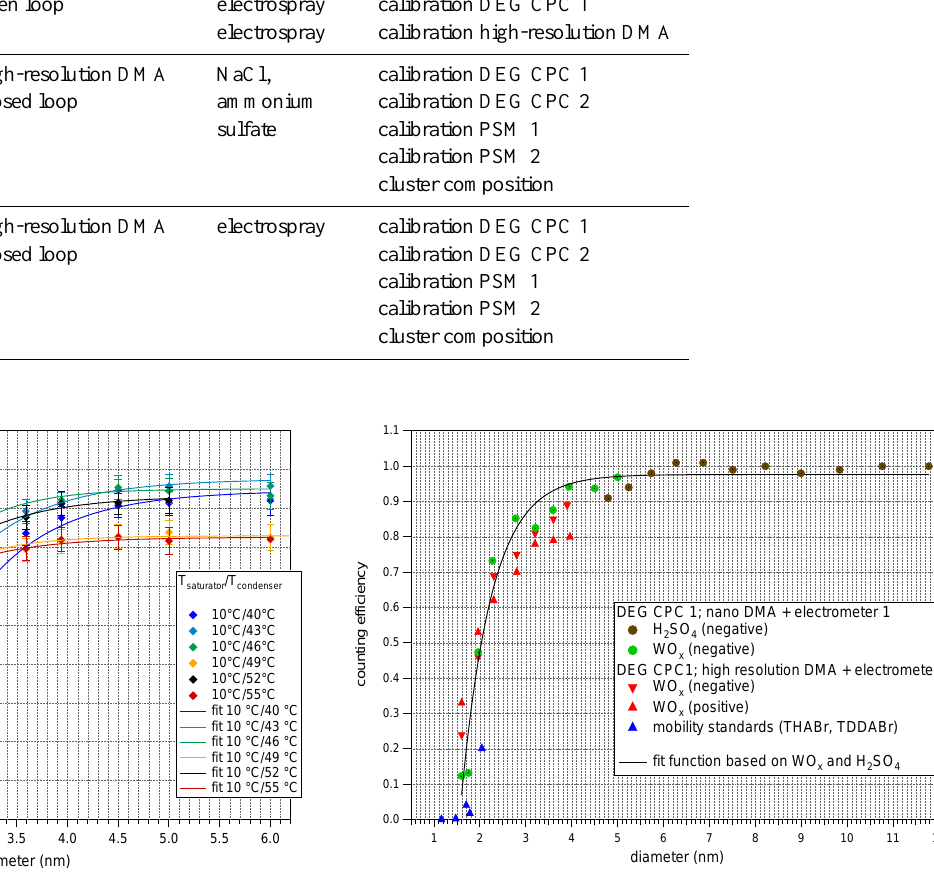
Fig. 5. Detection efficiencies for the DEG CPC 1 for different parti- cle types of both polarities classified with a nano-DMA and a high- resolution DMA in open loop. For particles larger than 5nm, sul- furic acid was used as test aerosol. The tungsten oxide measure- ments stop at 4nm, because with the applied settings for the high- resolution DMA, the biggest size that can be selected is 4nm. Mo- bility standards are not included for the